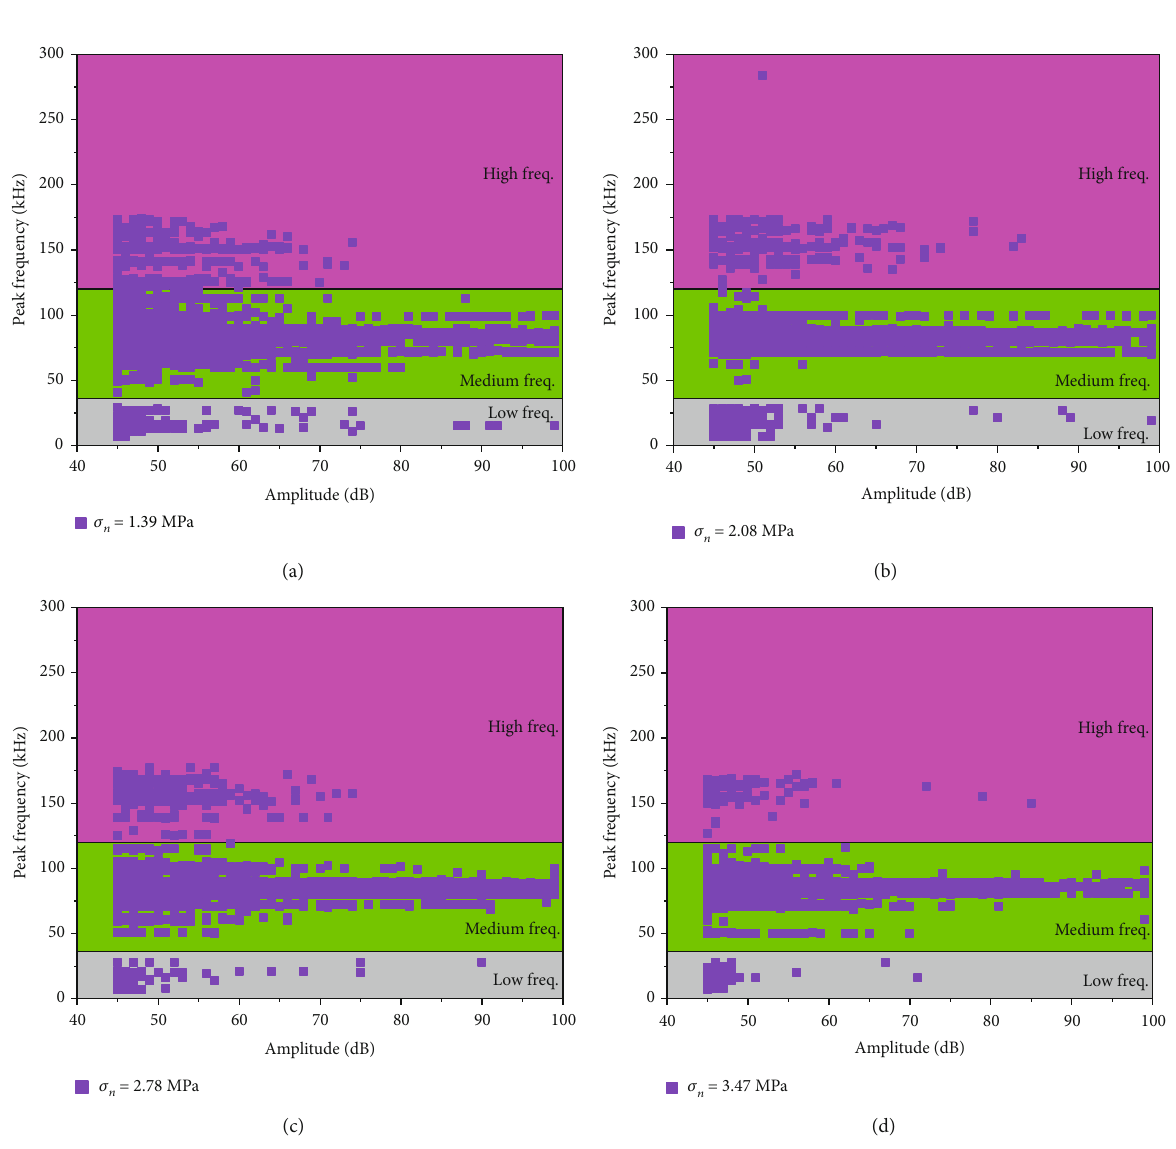
Figure 13: The frequency and amplitude distribution characteristics of rock joint shearing under four normal stresses.